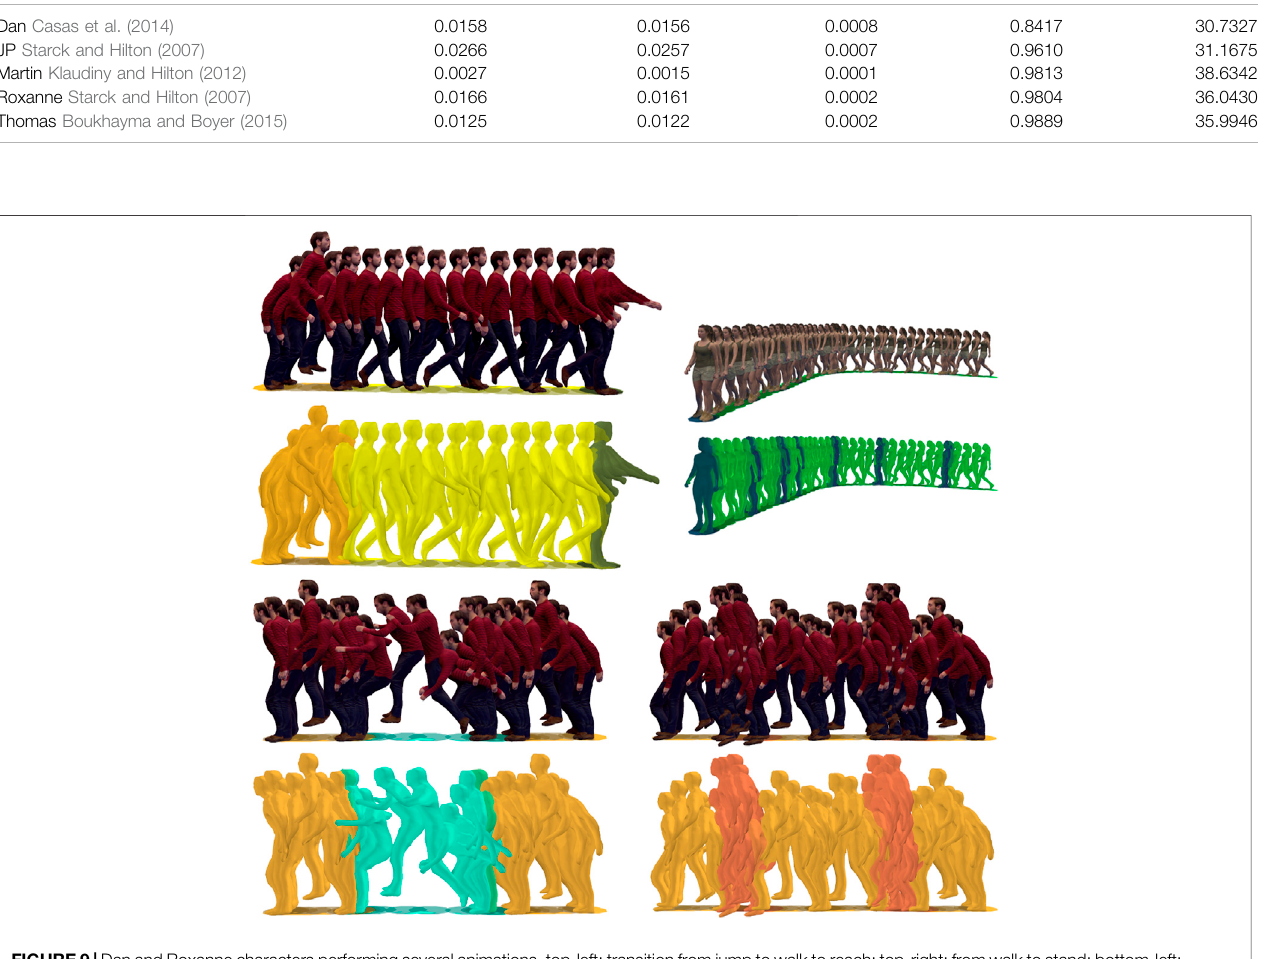
Frontiers in Virtual Reality |